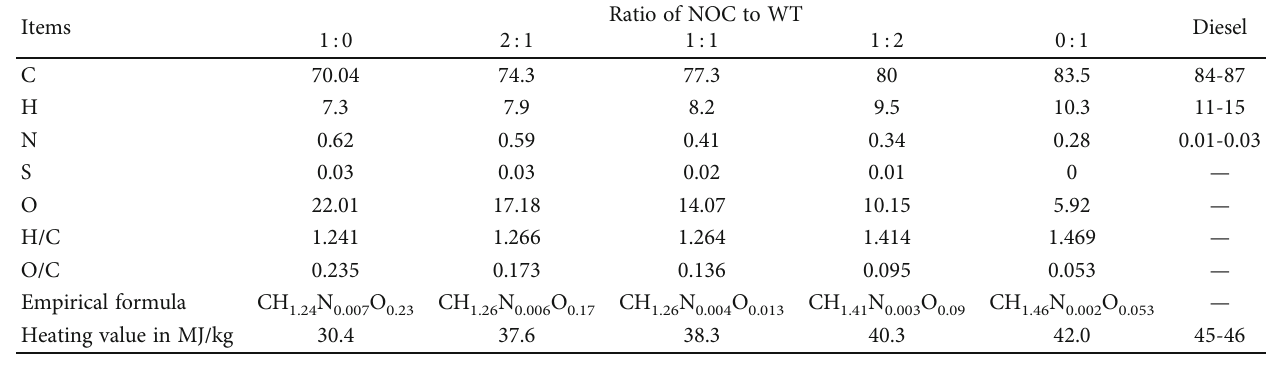
Table 3: Copyrolysis oil properties obtained at di ff erent blending ratios.